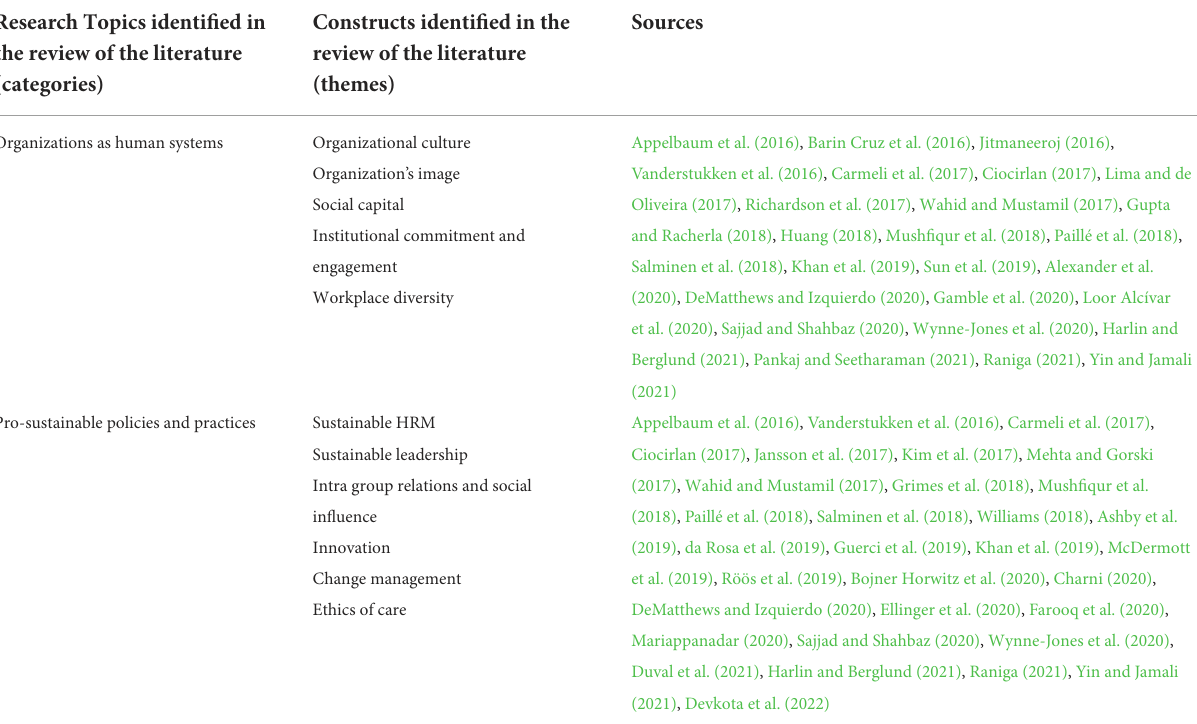
TABLE 4 Organization-focused Research Topics and